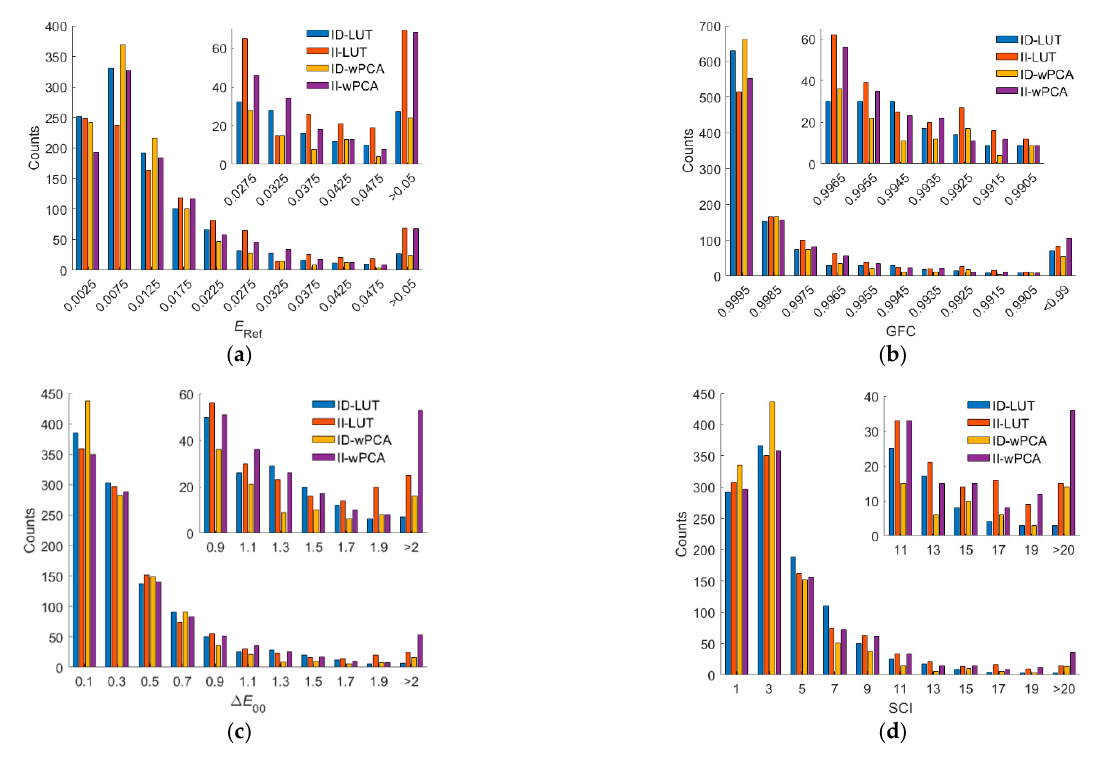
Figure 13. ( a ) E Ref , ( b ) GFC, ( c ) Δ E 00 , and ( d ) SCI histograms for the 1066 test samples. The camera is the D5100 camera. The corresponding spectrum reconstruction methods are shown in figures. The insets show enlarged parts.